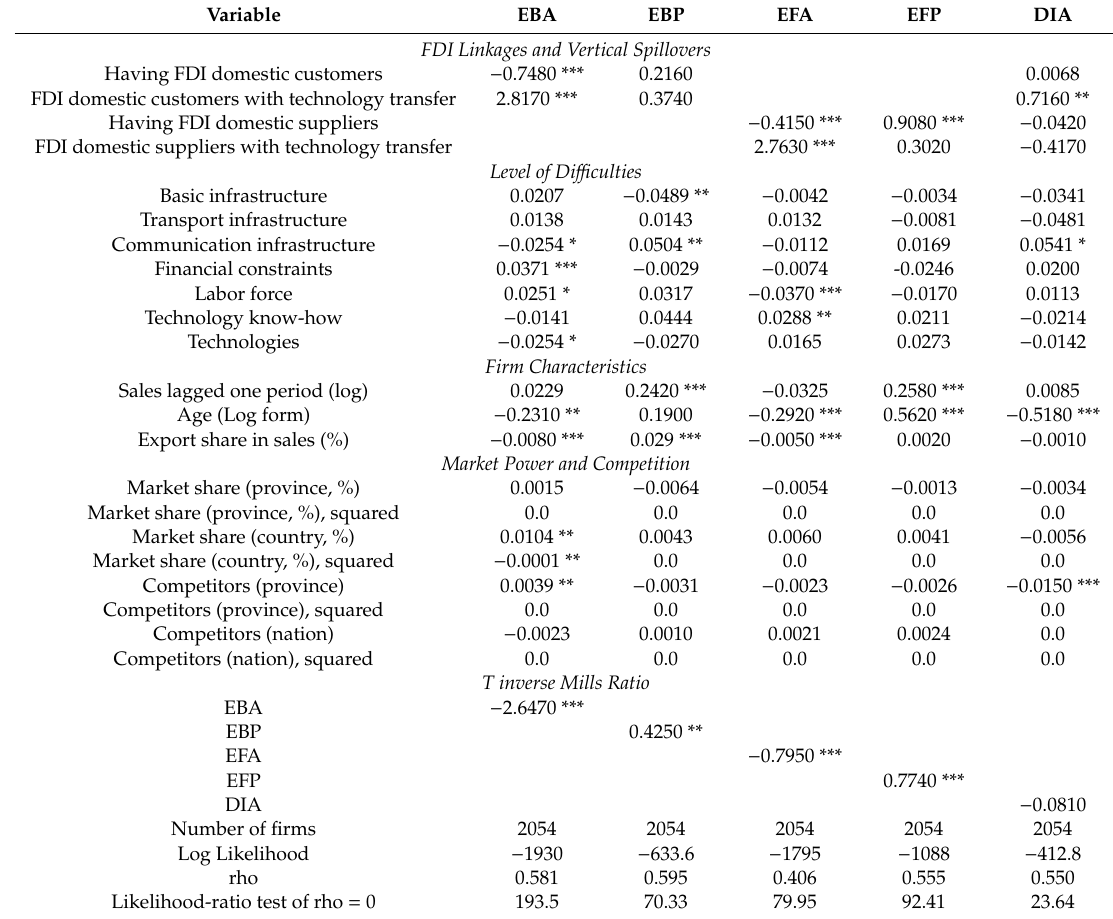
Table 5. Impact of constraints, foreign direct investment (FDI) linkage and vertical spillovers (marginal e ff ect),